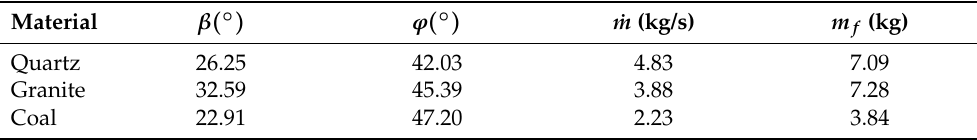
Figure 5. Binaries images of the DDT of coal: ( a ) upper left image, ( b ) upper right image, ( c ) lower left image and ( d ) lower right image. These images are processed from the photographs obtained in the experimental test. Table 6. Experimental results of the Draw Down Test. Angle of repose, shear angle, mass flow rate and final mass of each